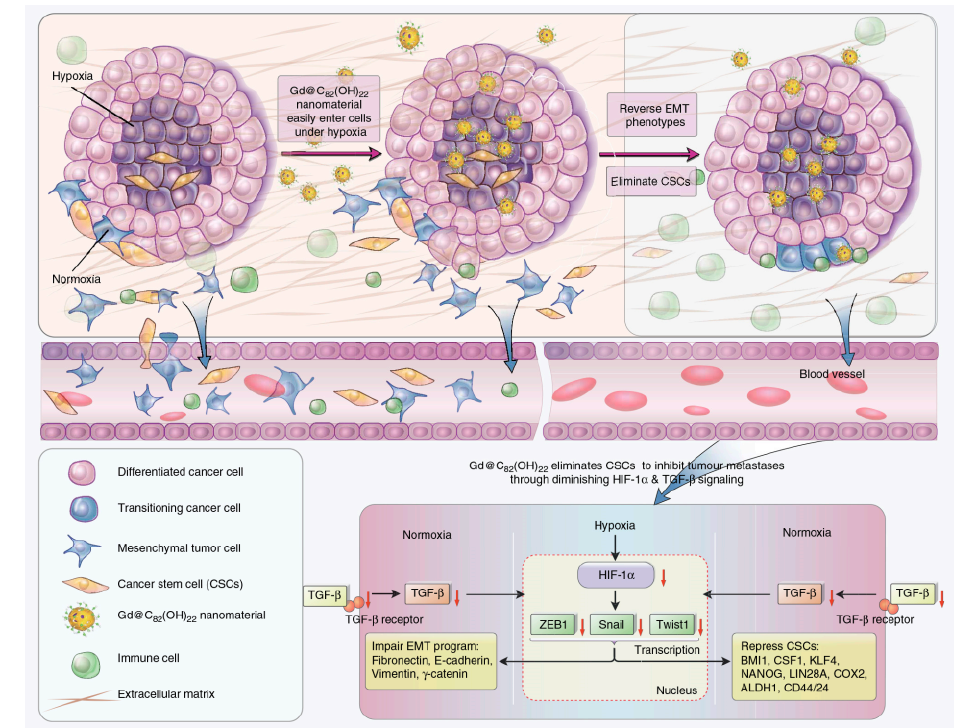
Figure 5. Key pathways by which Gd@C 82 (OH) 22 NPs suppresses tumor growth